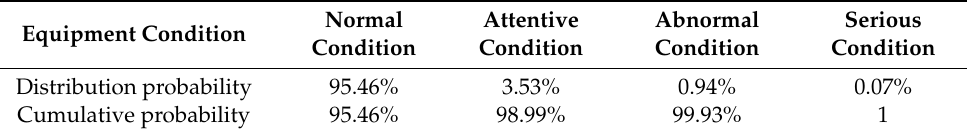
Table 2. The data of 220kV transformers.